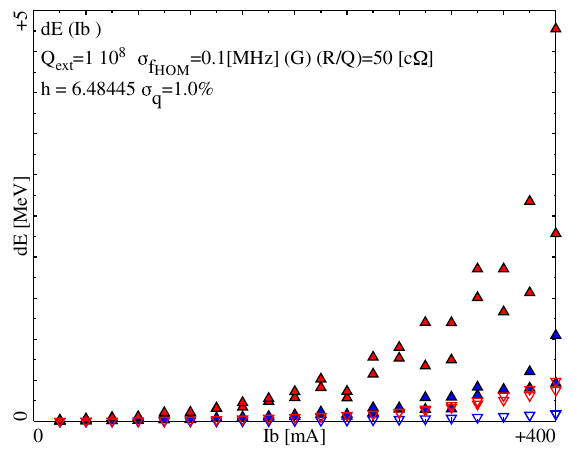
FIG. 29. (Color) dE as a function of I B for two consecutive pulses with Q ext ¼ 10 8 , (cid:1) (cid:3) f ¼ 100 kHz ; red: worst bunch in pulse; blue: rms; filled upward triangles: with 1% charge scatter; hollow downward triangles: without bunch noise.